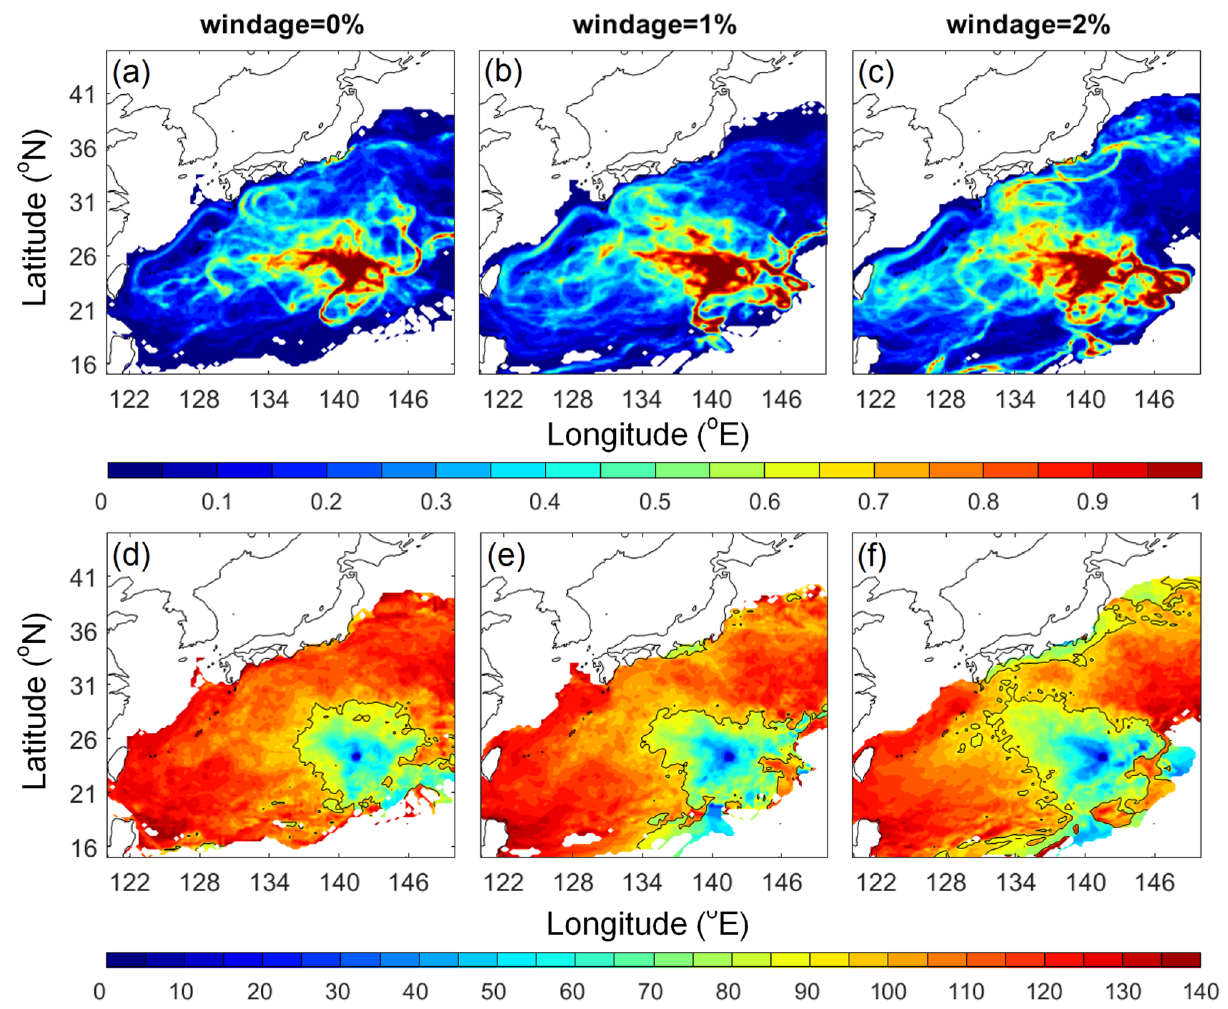
Figure 4. ( a – c ) Normalized visitation frequency and ( d – f ) time-evolving distribution (days) based on 28 years’ (1993–2020) daily hindcast ocean currents with windage of ( a , d ) 0%, ( b , e ) 1%, and ( c , f ) 2%. 90-day contour is shown in black in ( d – f ). Figure is created using MATLAB R2011b (http:// www. mathw orks.